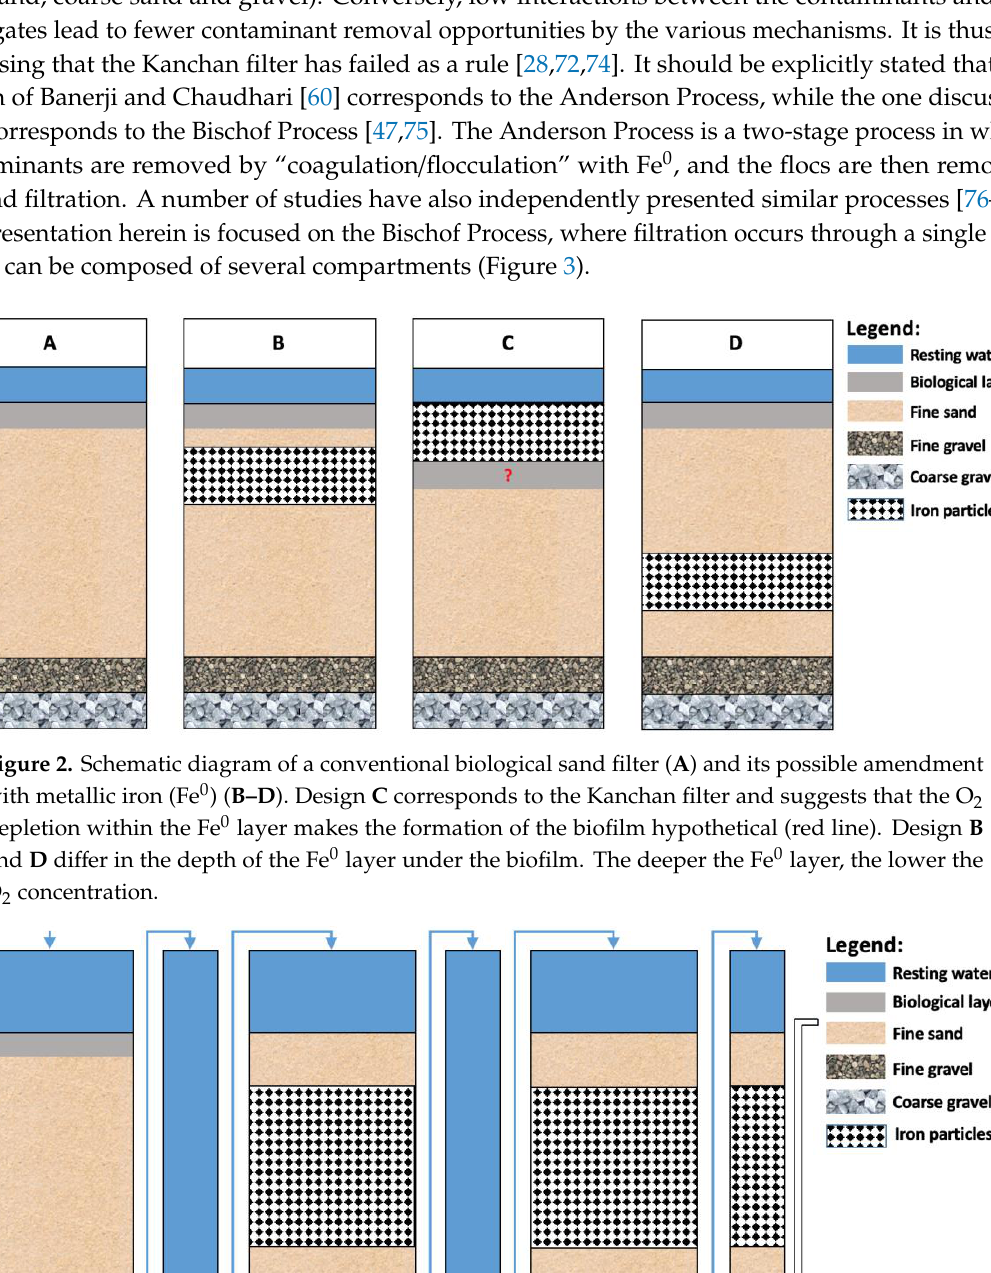
Figure 2. Schematic diagram of a conventional biological sand filter ( A ) and its possible amendment with metallic iron (Fe 0 ) ( B , C , D ). Design C corresponds to the Kanchan filter and suggests that the O 2 depletion within the Fe 0 layer makes the formation of the biofilm hypothetical (red line). Design B and D differ in the depth of the Fe 0 layer under the biofilm. The deeper the Fe 0 layer, the lower the O 2 concentration.